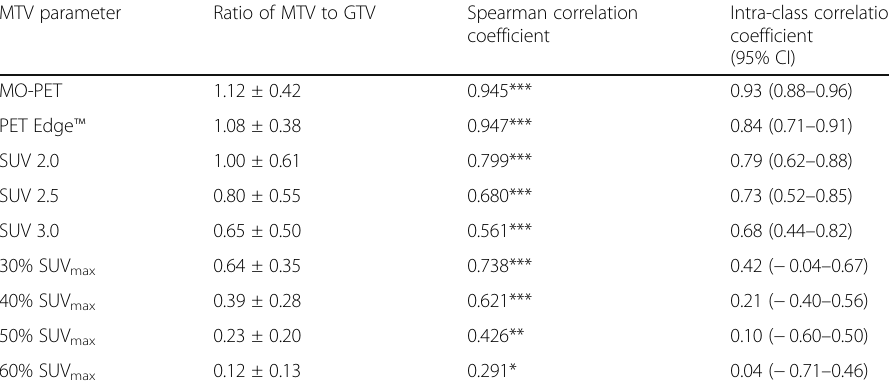
Table 2 Correlation between PET MTVs and MRI GTV MTV parameter Ratio of MTV to GTV Spearman correlation